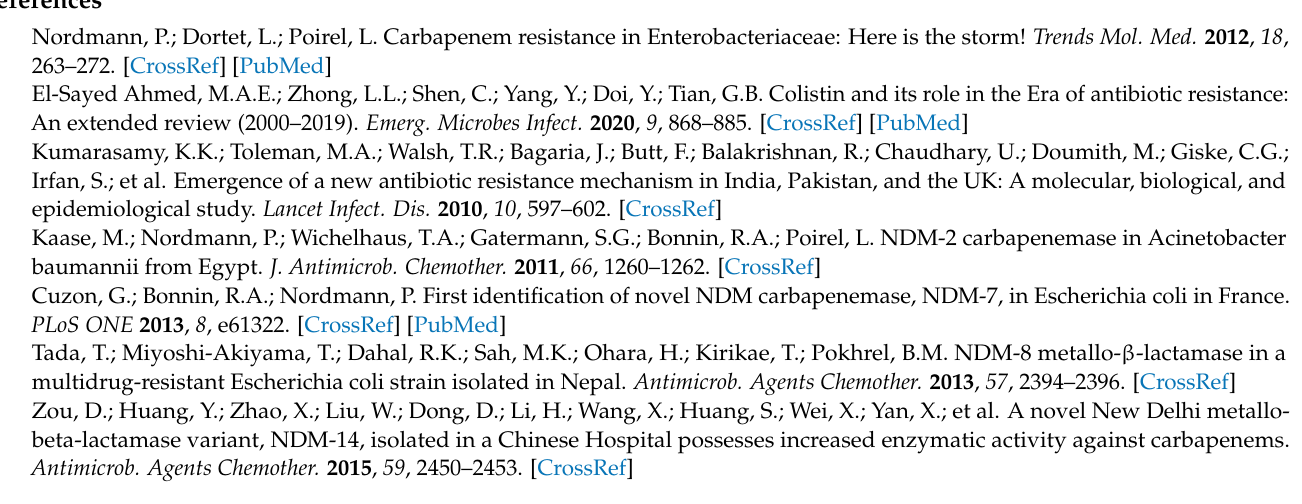
Supplementary Materials: The following are available online at https://www.mdpi.com/2079-6 Table S2. Primers for bla NDM and mcr screening and CDS amplification. Figure S1. Geographic distribution and frequency of the specimens collected from 2010 to 2020. The color shades represent different years and the pie area reflects the number of samples collected in each region. Abbreviations: BJ = Beijing, AH = Anhui, GS = Gansu, YN = Yunnan, GX = Guangxi, GZ = Guizhou, NX = Ningxia, IM = Inner Mongolia, QH = Qinghai, ZJ =